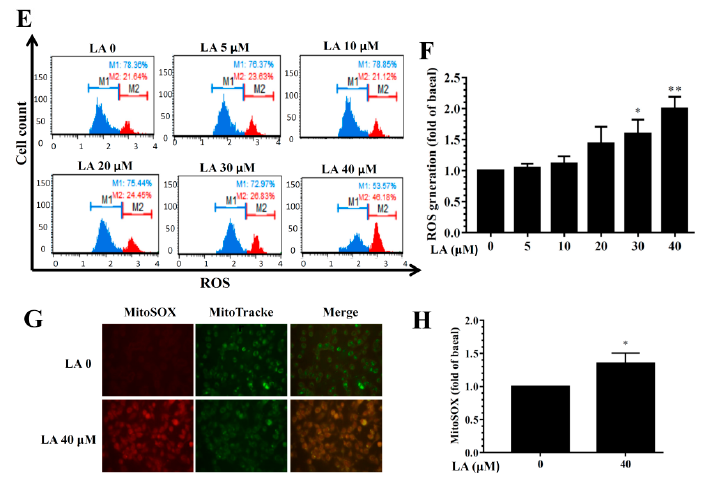
Figure 9. Effects of licochalcone A (LA) on reactive oxygen species (ROS) production in MDA-MB-231 cells. ( A ) ROS levels detected in MDA-MB-231 cells treated with 0-40 μ M LA. ( B ) ROS